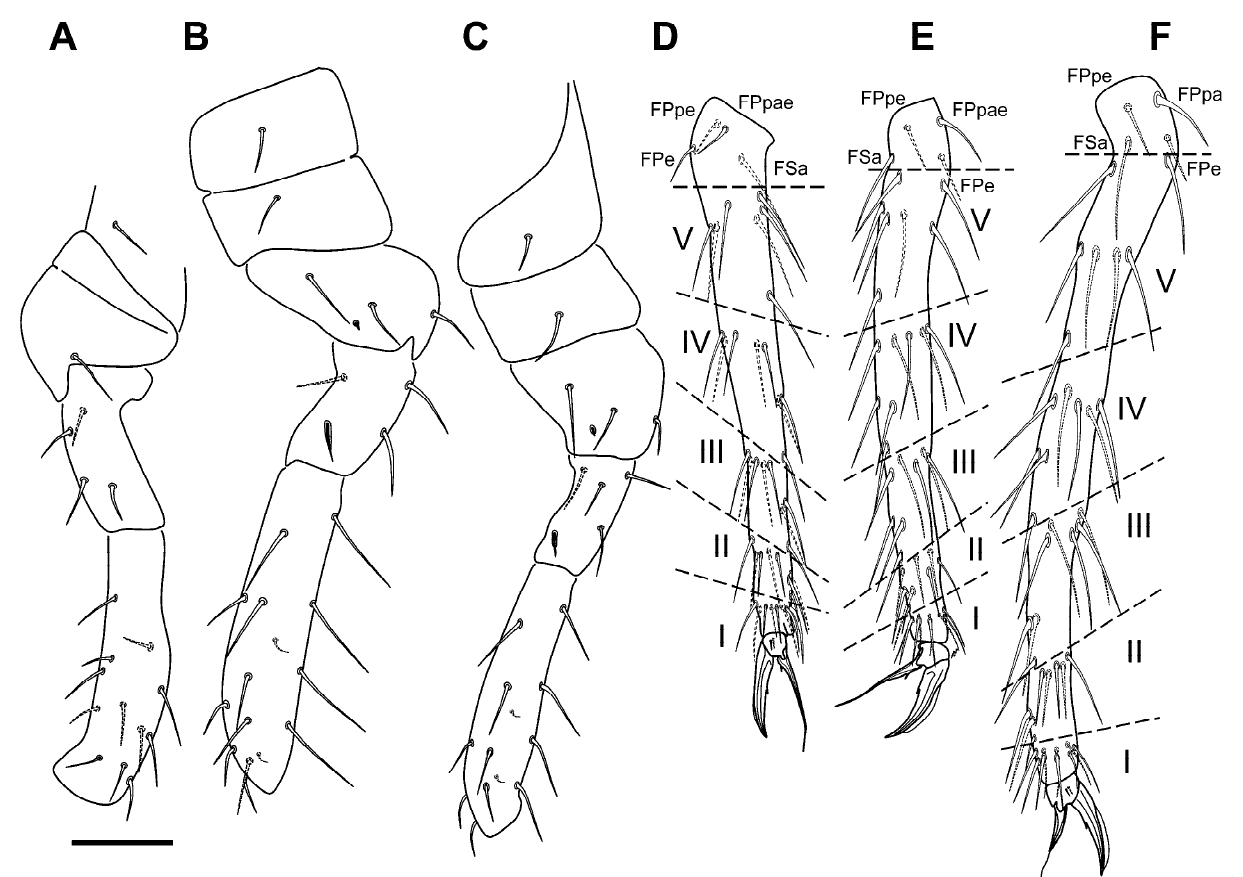
Figure 5. Pygmarrhopalites custodum Baquero and Jordana sp. nov.: ( A – C ) precoxa 1 to femur of legs 1 to 3 (L1, posterior view; L2–L3, anterior view); ( D – F ) tibiotarsus, claw, and empodium of L1 to L3 (all external view) (scale bar: 0.05 mm).